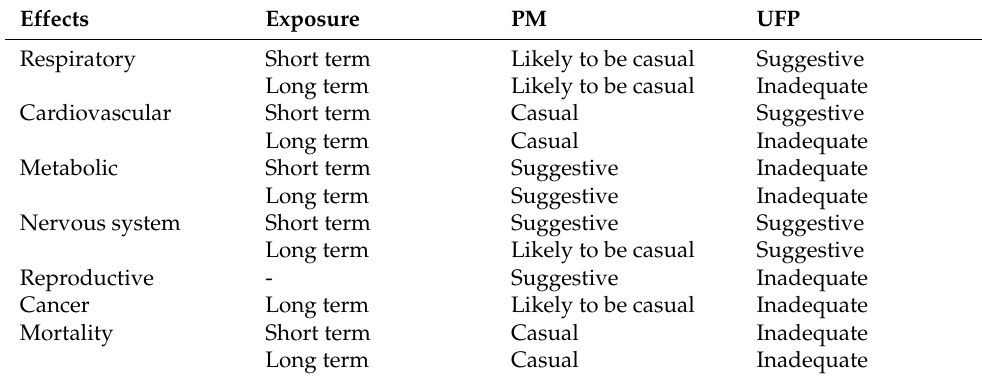
Table 2. Health effects from exposure to PM (particulate matter) and ultrafine particles (UFP)